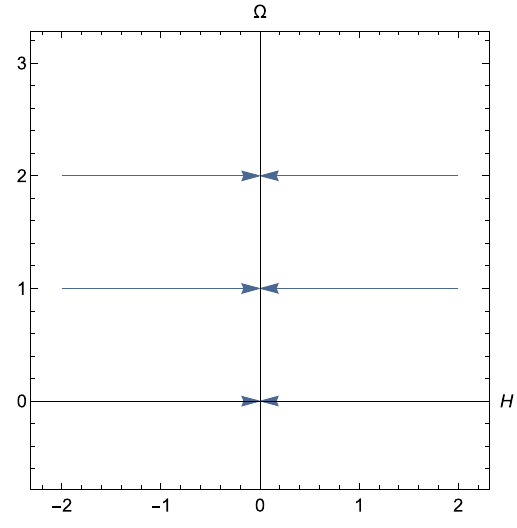
Fig. 3 Phase portrait of the system (2.27)–(2.28) for γ = − 1 / 2. Every point on the (cid:4) axis is an equilibrium